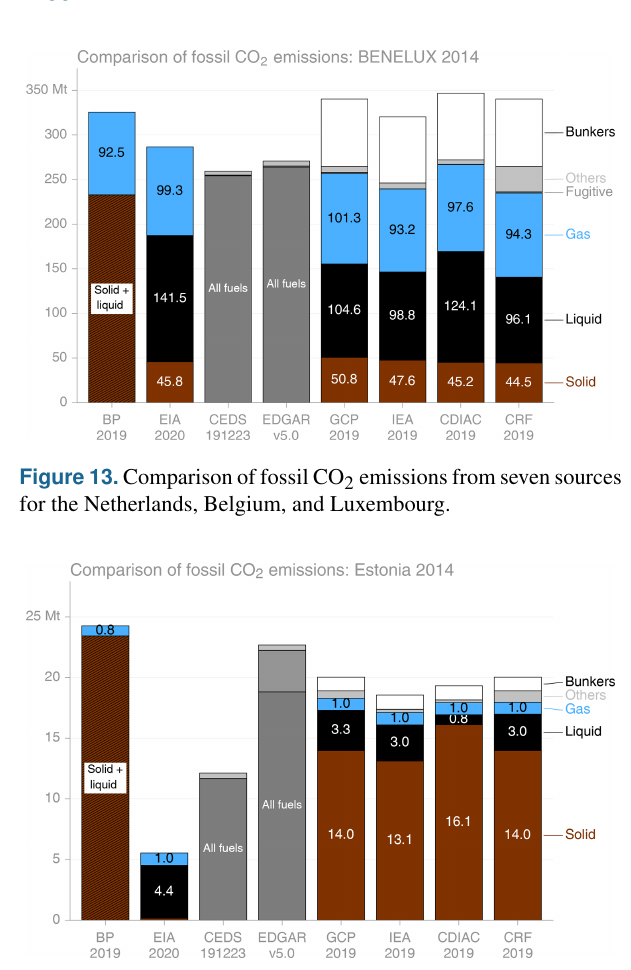
Figure 14. Comparison of fossil CO 2 emissions from seven sources for Estonia.